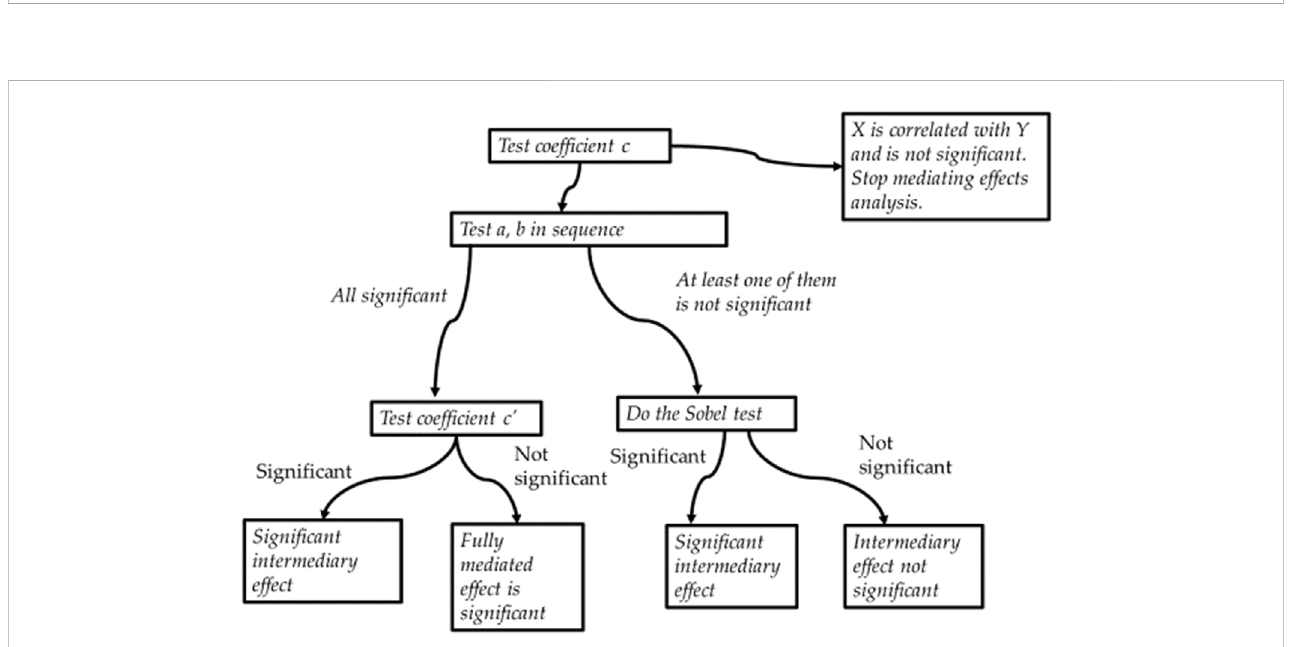
FIGURE 4 Flow chart of the mediating